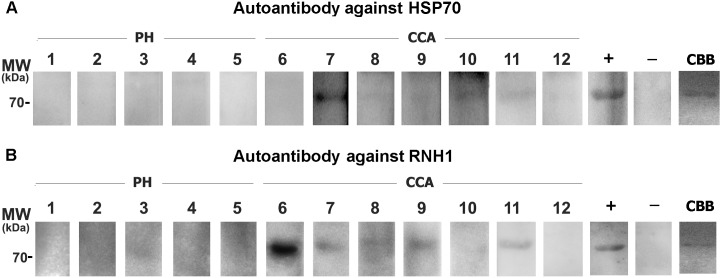
Western blotting analysis of HSP70 and RNH1 autoantibodies.Panel A) Recombinant human HSP70 was incubated with plasma of healthy individuals (lane 1–5) and patients with CCA (lanes 6–12). Immunoreactive bands were detected in 5/7 patients and none of the healthy controls. Panel B) Recombinant human RNH1 was incubated with plasma of healthy individuals (lane 1–5) and patients with CCA (lanes 6–12). Immunoreactive bands were detected in 6/7 patients and was weak in controls. Recombinant HSP70 and RNH1 proteins were probed with pooled healthy plasma served as negative controls (−) and pooled plasma from patients with CCA served as positive controls (+). HSP70 and RNH1 proteins were also demonstrated by staining with coomassie brilliant blue (CBB). PH  =  healthy individuals, CCA  =  cholangiocarcinoma.